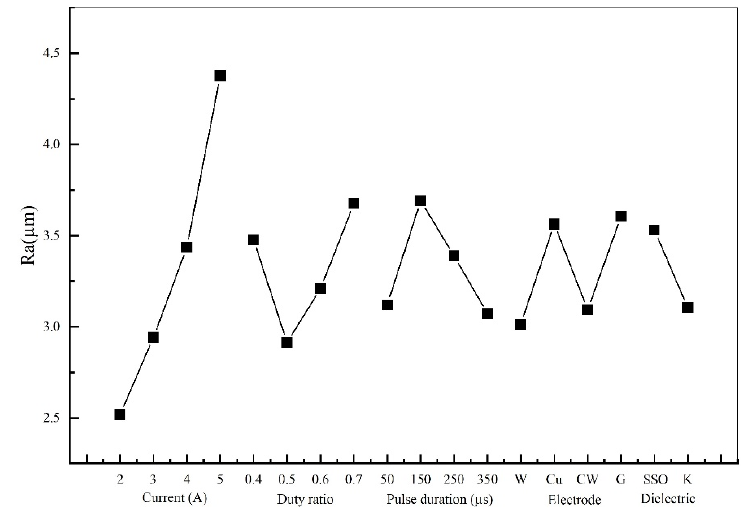
Figure 4. The influence of current, duty ratio, pulse duration, electrode and dielectric on Ra.